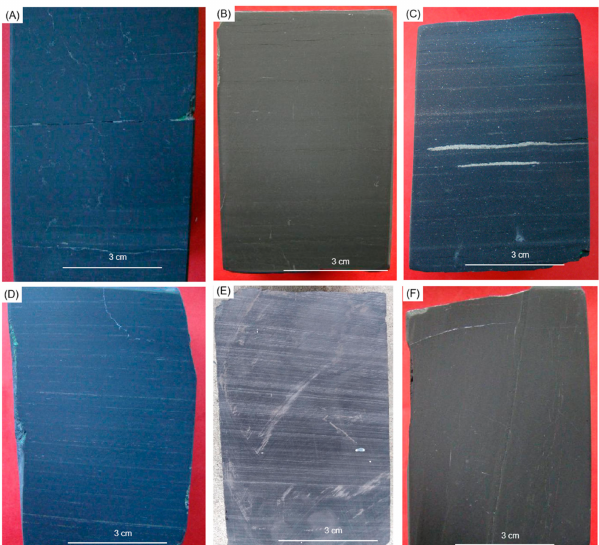
Figure 7. Core and outcrop photos showing general characteristics under the naked eye of shale with various depositional structures in the Wufeng–Longmaxi shale in the Sichuan Basin of southwestern China. ( A ) PL, with weakly linear lighter color banding occurring alternated with darker layers (sample number 8-31, Longmaxi Formation); ( B ) GL-C, the colors of the adjacent beds often show a slight differences (sample number 4-2, Wufeng Formation); ( C ) GL-SC (sample number: 9-19-1, Longmaxi Formation) and ( D ) GL-SC (sample number 10-12, Longmaxi Formation), and the shale has a distinct “striped” appearance of alternating lighter and darker layers as well as intermittent bright calcite beds; ( E ) IL (sample number 2018-12, Longmaxi Formation) from borehole Ning 212, and paler beds alternate with darker beds; ( F ) SB (sample number 5-29, Wufeng Formation) from Shuanghe outcrop in Changning County, and the shale is massive and shows no obvious lamination, bedding or